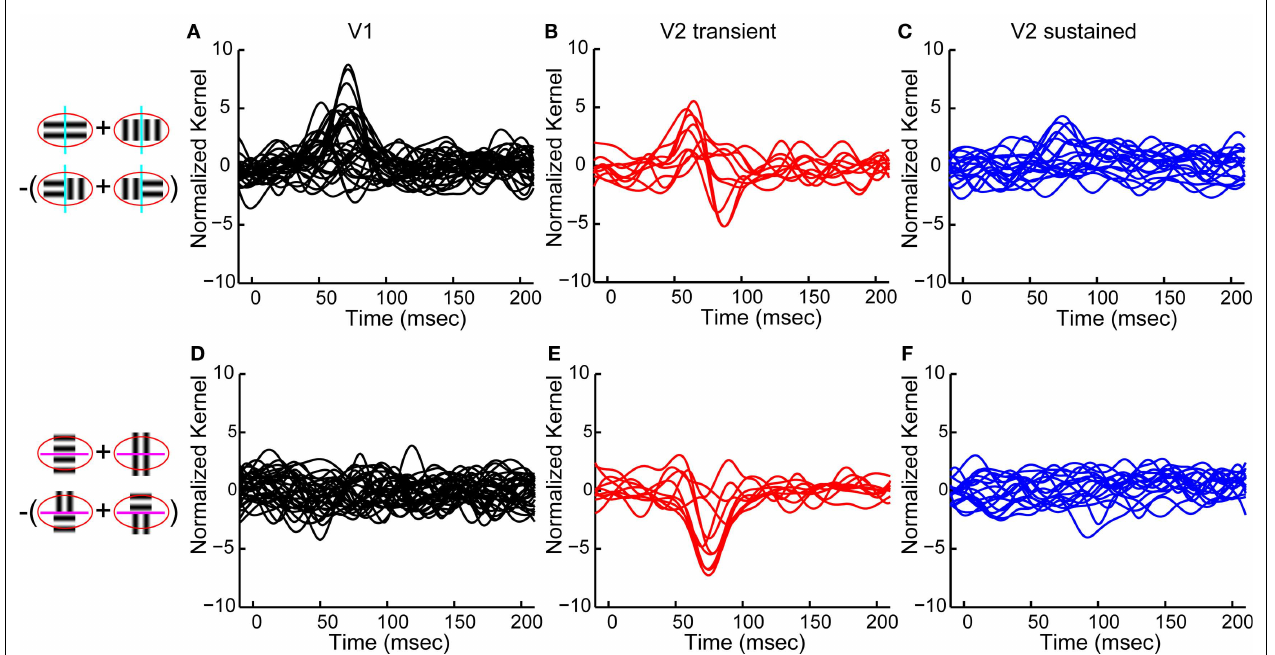
FIGURE 5 | Population summary of spatial second-order response kernels. Schematics on the left illustrate the computations of spatial second- order responses across boundaries orthogonal to the receptive fi eld (top, cyan lines), and across boundaries parallel to the receptive fi eld (bottom, magenta lines). The red ellipse stands for the classical receptive fi eld. (A) Normalized second-order response kernels across boundaries orthogonal